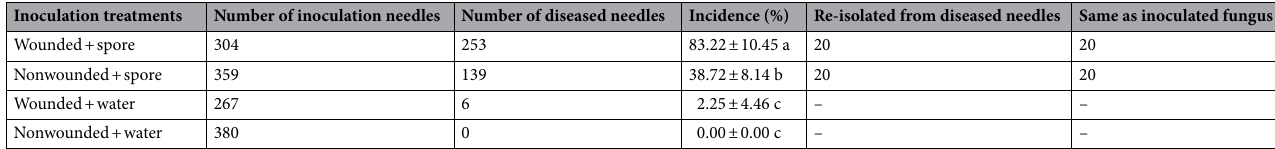
Table 4. Pathogenicity of S. sapinea to healthy P. sylvestris var. mongolica. Incidence followed by different letters were significantly different according to the Tukey’s HSD test (p <